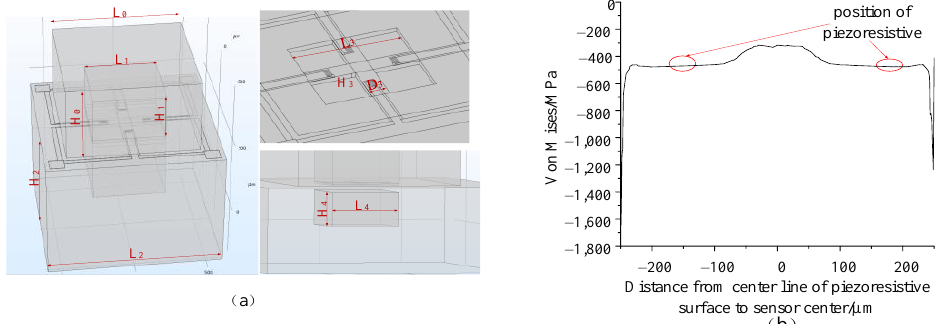
Figure 6. ( a ) Schematic diagram of the dimensions of the all-silicon bulk-type structure, and ( b ) stress curves in the piezoresistive placement area.